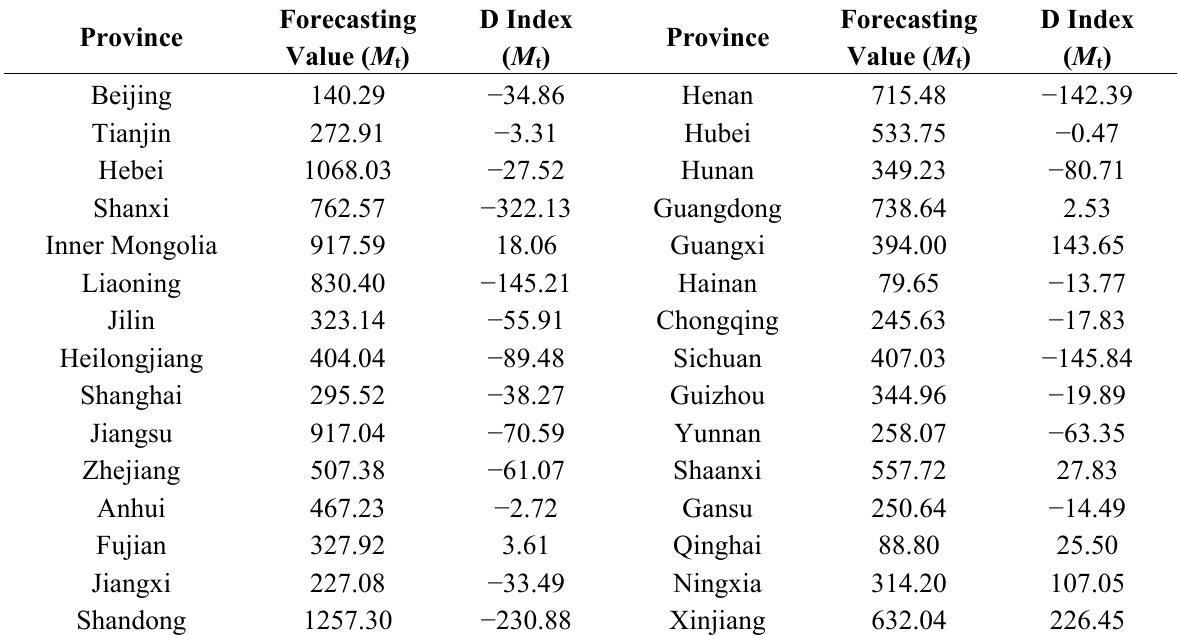
Table 3. Forecasting emissions in 2015 and D